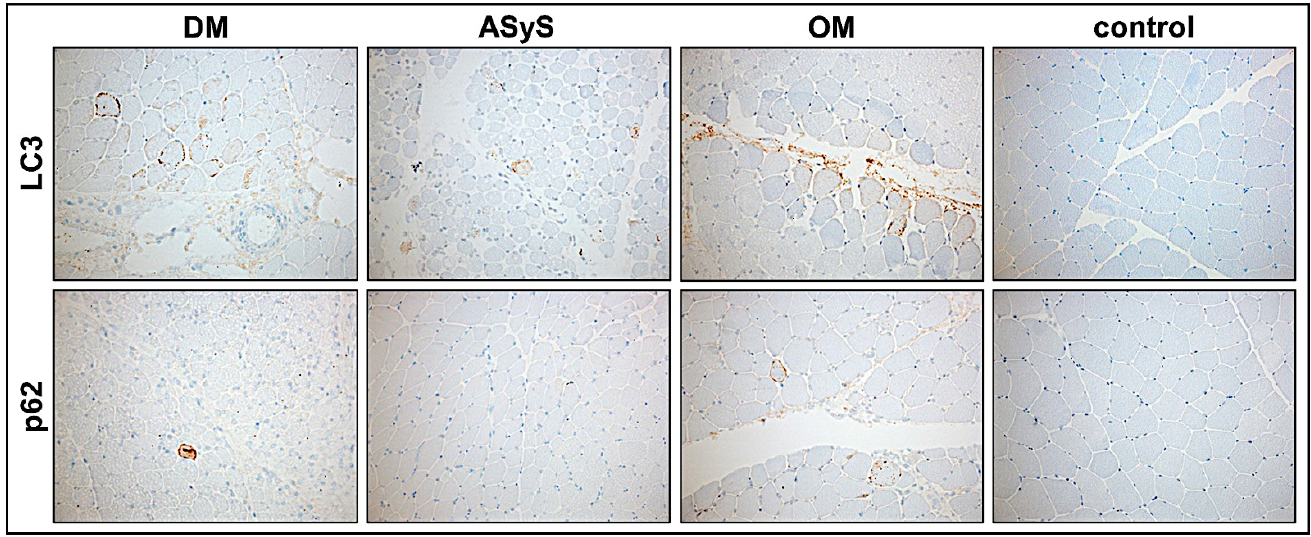
Figure 8. Expression of autopathic markers LC3 and p62 in jIIM muscle biopsies of patients with DM (P4), ASyS (P14), OM (P3), and control. Few muscle fibers expressing LC3 and p62 are present in DM (P4), ASyS (P14), and OM (P3), indicating a moderate upregulation of autophagy (magnification 20×). (DM = dermatomyositis; ASyS = antisynthetase syndrome; OM = overlap myositis).